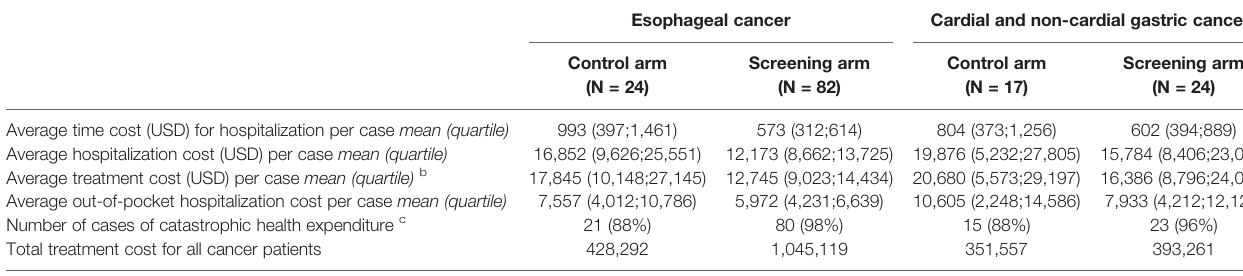
TABLE 2 | Treatment costs for subjects included in the “ Perfect Cohort ” from the ESECC a trial.